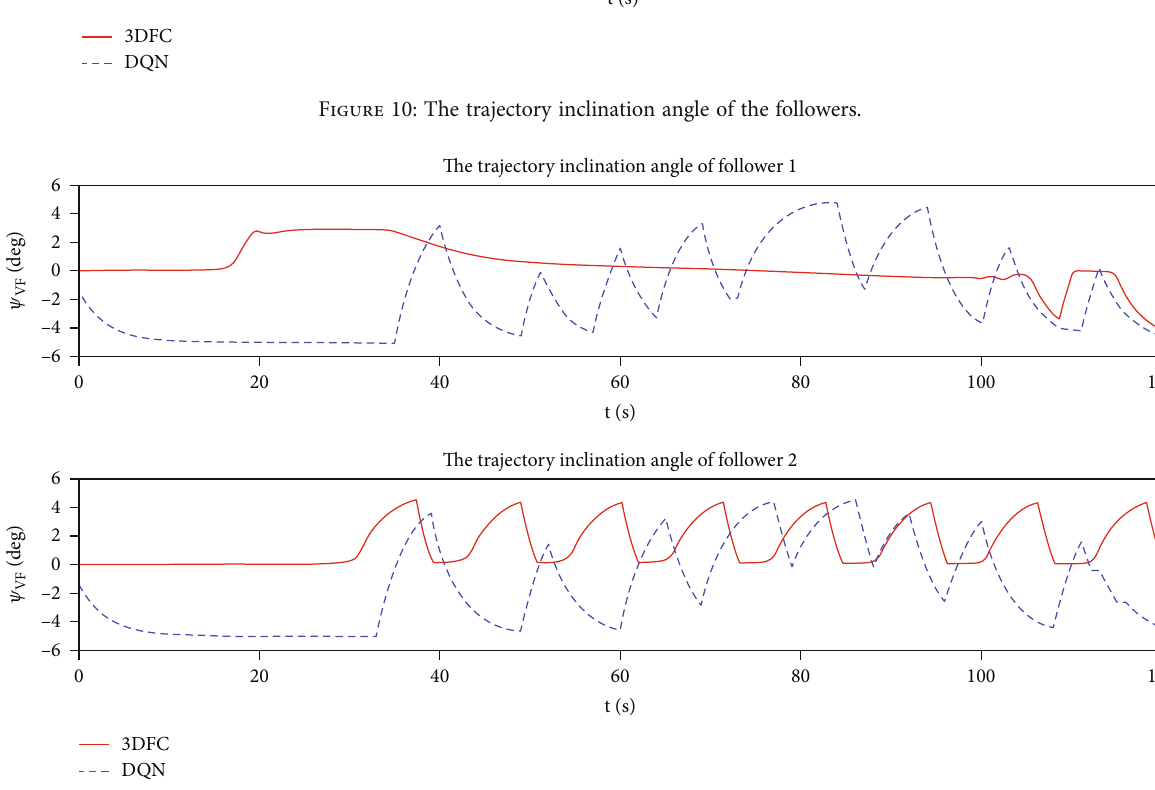
Figure 11: The ballistic de fl ection angle of the